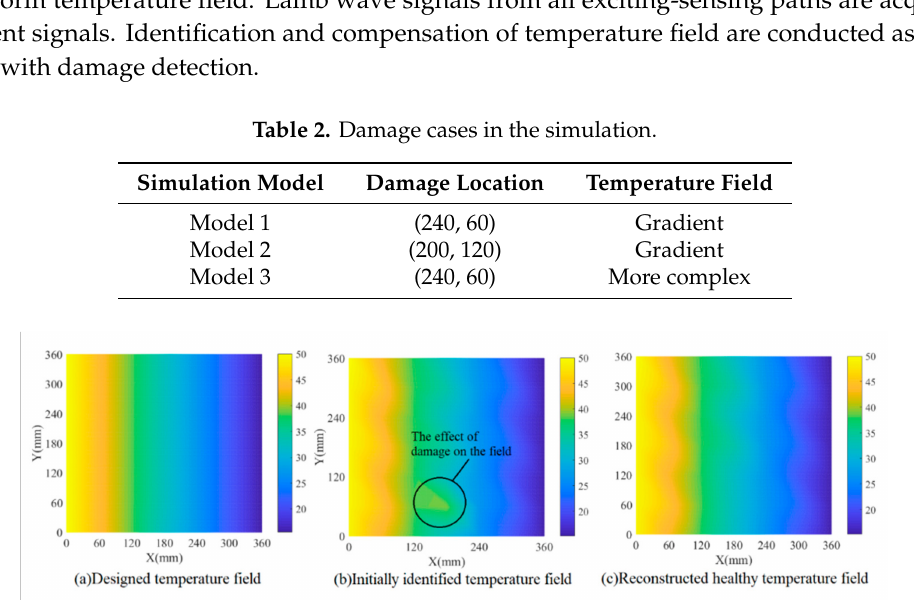
Figure 6. Temperature field identification results of simulation model